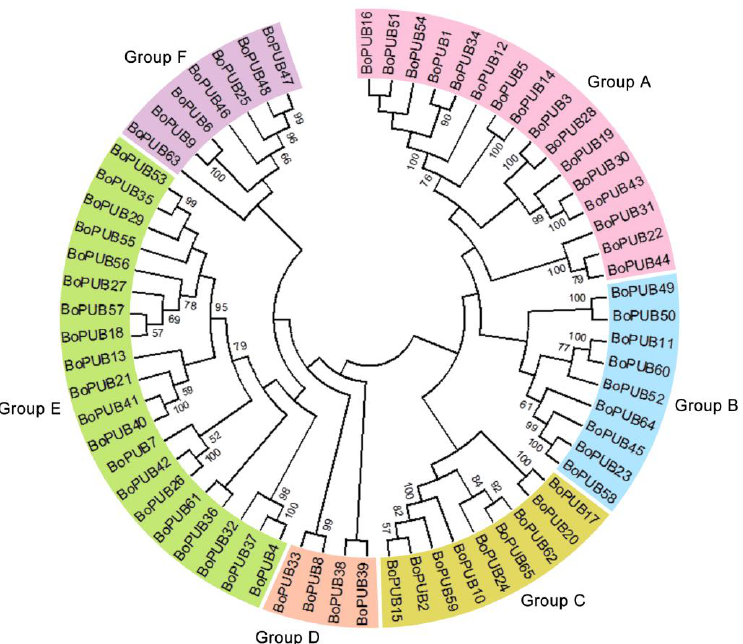
Figure 1. Phylogenetic relationships of BoPUB genes. The sequence alignment of 65 BoPUB proteins was conducted by Clustal Omega. A phylogenetic tree based on the alignment above was constructed by the neighbor-joining (NJ) method with 1000 bootstrap replicates. The BoPUB gene family members are divided into six groups (Group A–F). The genes in different groups are highlighted in six different colors, respectively.